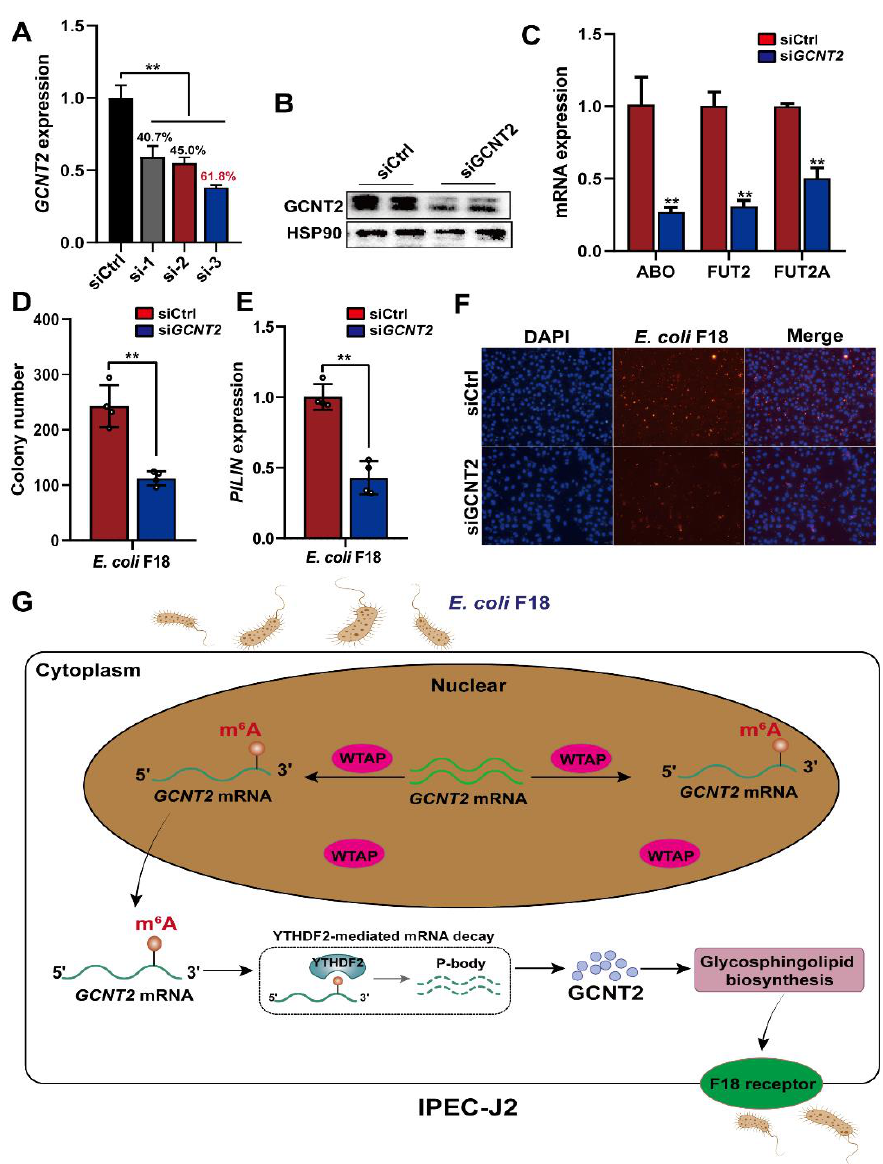
Figure 6. WTAP affects the formation of E. coli F18 receptor by inhibiting glycosphingolipid biosyn- thesis pathway. ( A , B ) Knockdown efficiency of IKBKG gene in IPEC-J2 was assessed using qPCR and Western blot analysis. ( C ) Expression detection of glycosphingolipid biosynthesis-related genes in IPEC-J2 cells with or without GCNT2 knockdown. ( D – F ) Effect of GCNT2 knockdown on the ability of E. coi F18 fimbria to adhere to IPEC-J2 cells was analyzed by colony counting, PILIN expression detection, indirect immunofluorescence assay. ( G ) A working model summarizing the mechanism of m 6 A modification and its modulators in regulating E. coli F18 susceptibility in IPEC-J2 cells. m 6 A methyltransferase WTAP increases the m 6 A levels of GCNT2 mRNA, leading to WTAP attenuating the YTHDF2-dependent mRNA stability of GCNT2, WTAP thereby restraining the formation of E. coli F18 receptor by inhibiting GCNT2-mediated glycosphingolipid biosynthesis, resulting in the resistance of IPEC-J2 to E. coli F18 infection. All data are presented as the mean ± SD, ** p <